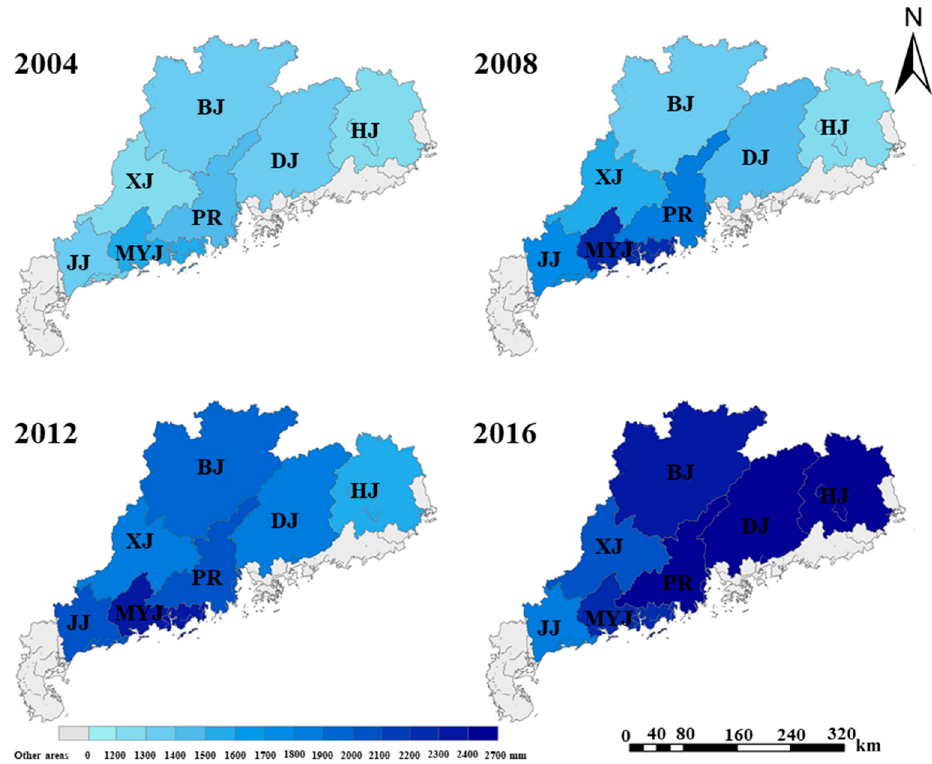
Figure 3. Spatial patterns of annual rainfall in the seven major basins in Guangdong.